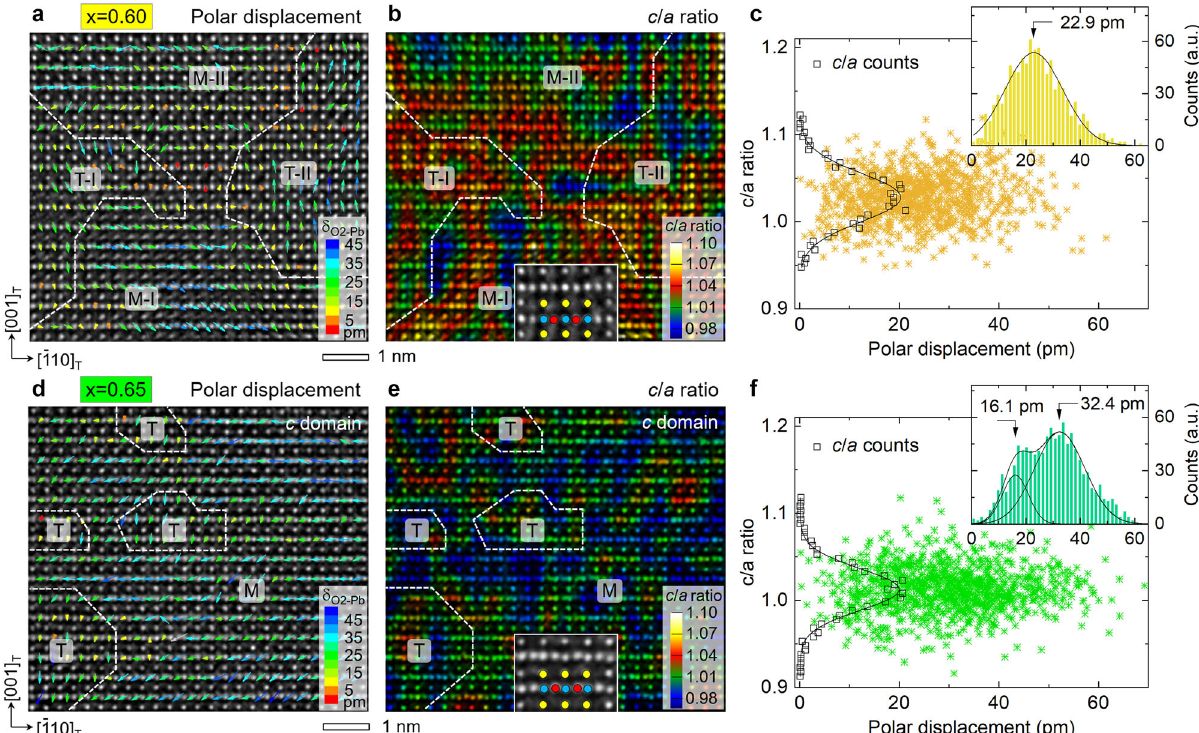
Fig. 2 Nanoscale phase coexistence and polarization – strain relation. a , d Atomic-resolution TEM image of x = 0.60 and 0.65 crystal recorded along [110] T direction and overlaid with a map of O 2 column displacements (color arrows) relative to the centers of Pb/O1 columns ( δ O2-Pb ), respectively. b , e Unit-cell-wise c/a ratio map (after interpolation) overlaid on the atomic-resolution TEM image of x = 0.60 and 0.65 crystal, respectively. The white dotted lines in ( a , b ) and ( d , e ) mark the tetragonal (T)/monoclinic (M) phase boundaries. The atomic column types are denoted with Pb/O1 — yellow, Zr/Ti — blue, O 2 — red. c , f Unit-cell-wise correlation of c / a ratio with O 2 polar displacement for the x = 0.60 and 0.65 crystal, respectively. The interior inset is a statistical pro fi le of the c / a ratio (squares) fi tted by a Gaussian function (solid line) and the right-side inset is a corresponding statistical histogram of the polar